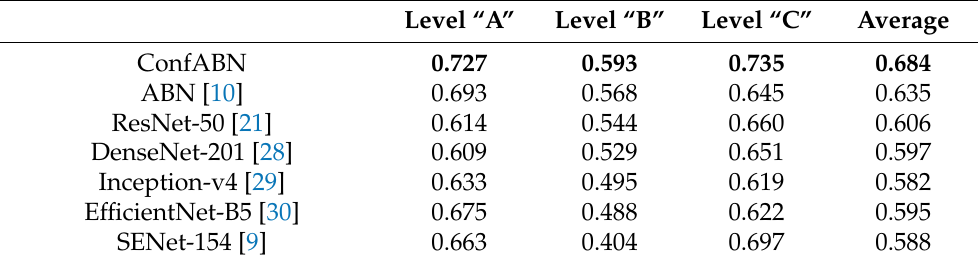
Table 4. F-measure of ConfABN and comparative methods in estimating deterioration levels of corrosion.